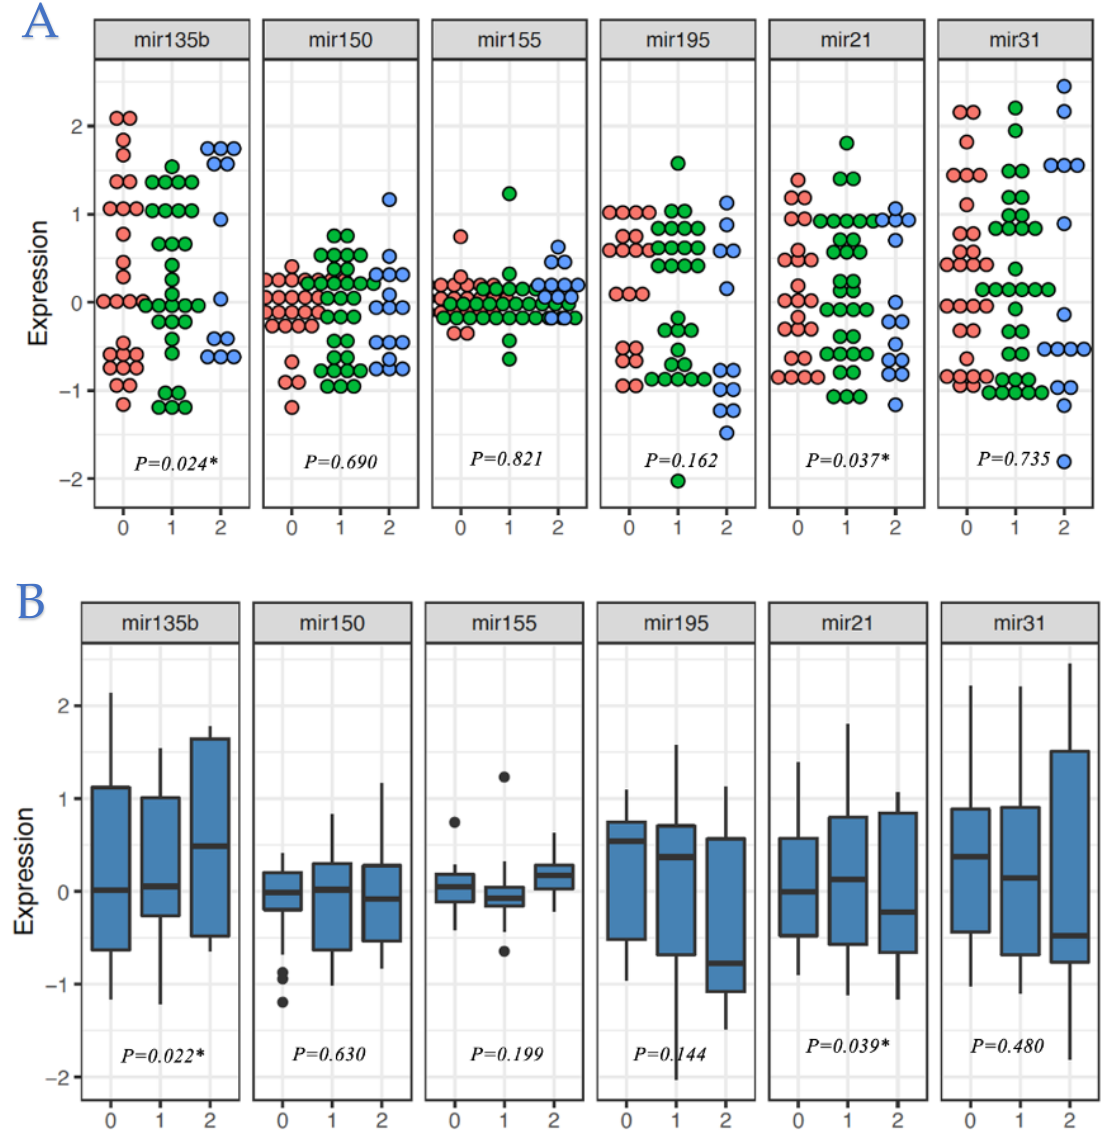
Figure 1. Dot plots and box plots displaying distribution of ( A ) median and ( B ) mean expression levels of the 6 target miRNAs within each nodal stage. * Denotes statistical significance at level p < 0.050.